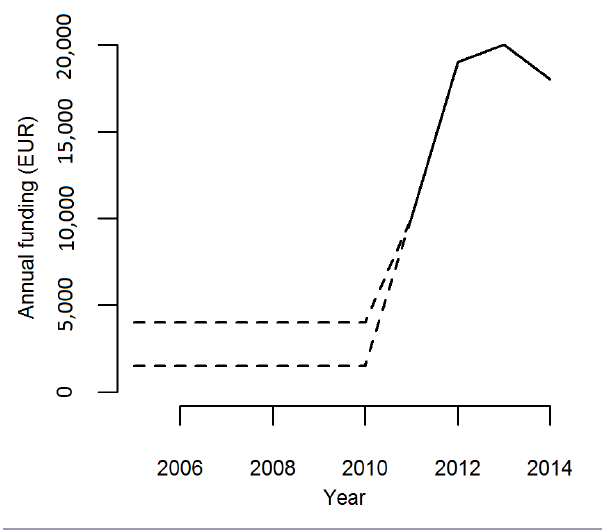
Fig. 1 . Annual funding by the Ministry of the Environment to the Pirkanmaa ELY center for false heath fritillary conservation in 2005-2014. Dashed lines depict the lower and upper bounds of estimated annual funds for the years 2005-2010, for which exact records per species were not available. The increased funding in 2011-2014 reflects a large-scale habitat restoration program that followed the 2009 habitat network survey and consisted of site maintenance, landowner contacts, and the development of new, experimental habitat maintenance methods. ELY center, Centre of the Economic Development, Transport and the